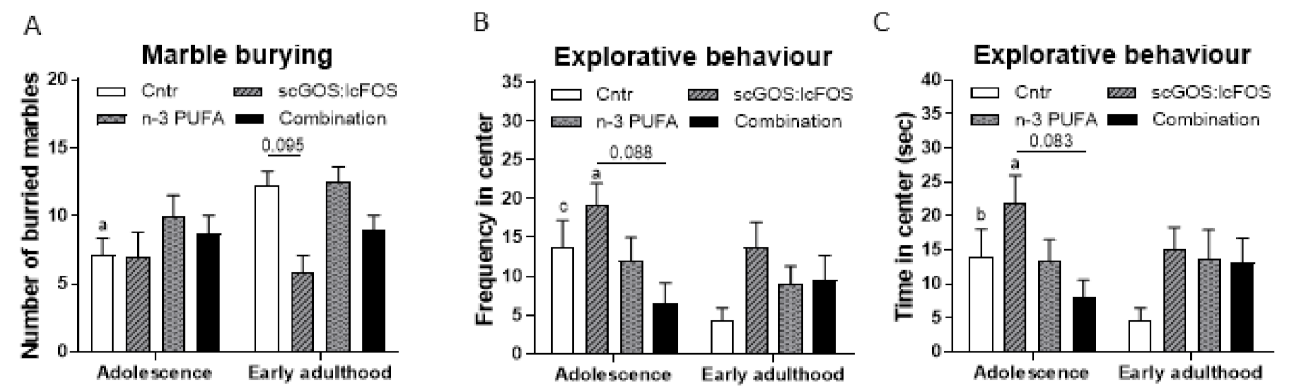
Figure 9. Anxiety-like behaviour assessed by marble burying and explorative behaviour in the open field. ( A ) Number of buried marbles by mice receiving the control, scGOS:lcFOS, n-3 PUFA or combination diet in adolescence and early adulthood ( B ) Explorative behaviour, the frequency the mice receiving the control, scGOS:lcFOS, n-3 PUFA or combination diet entered the centre of the open field in adolescence and early adulthood. ( C ) Explorative behaviour, the time the mice receiving the control, scGOS:lcFOS, n-3 PUFA or combination diet spent in the centre of the open field. ( A – C ): Data shown as the mean +/ − SEM. Analysed with mixed models, controlled for repeated measures, litter effect and Sidak’s multiple comparisons post hoc test. a = * p < 0.05 compared with early adulthood within diet group, b = ** p < 0.01 compared with early adulthood within diet group, c = *** p < 0.001 compared with early adulthood within diet group. ( A – C ): n = 8–10 mice per